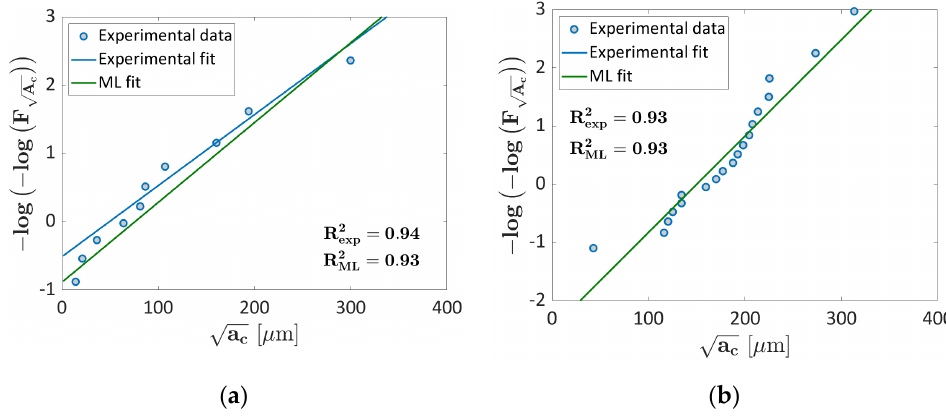
Figure 10. Gumbel plot for k = 4; ( a ) validation dataset; ( b ) training dataset.